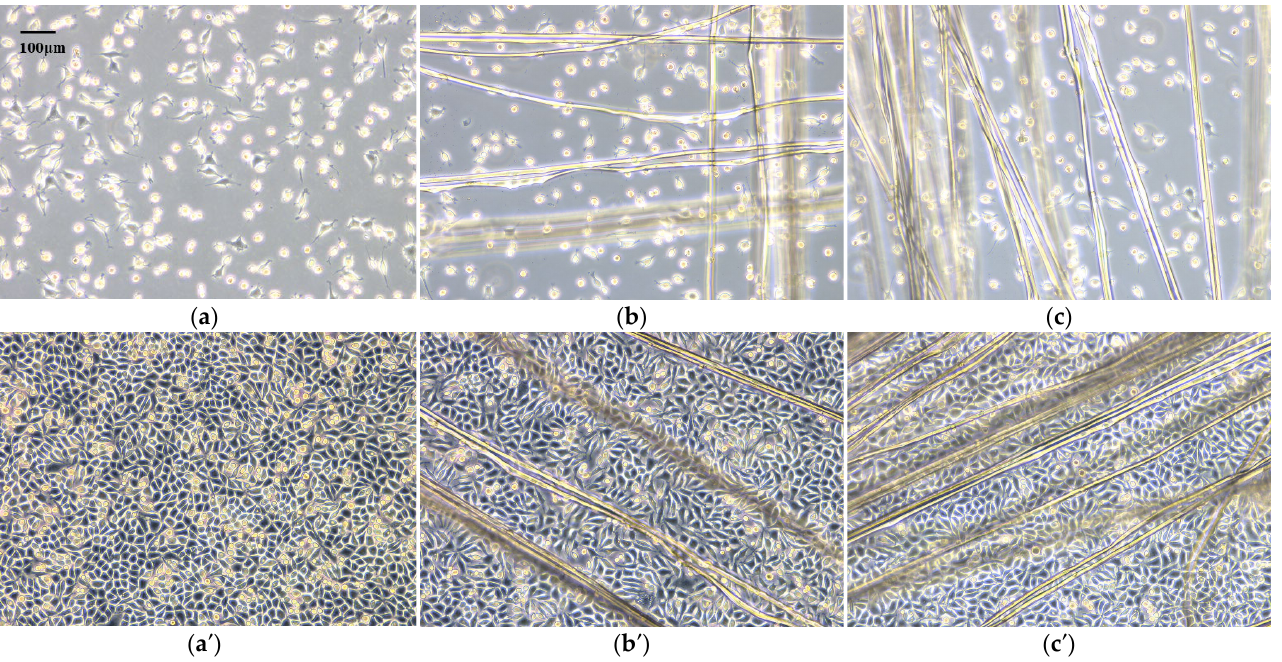
Figure 10. Silk scaffolds created by encircling a coverslip with silk fibroin fiber.